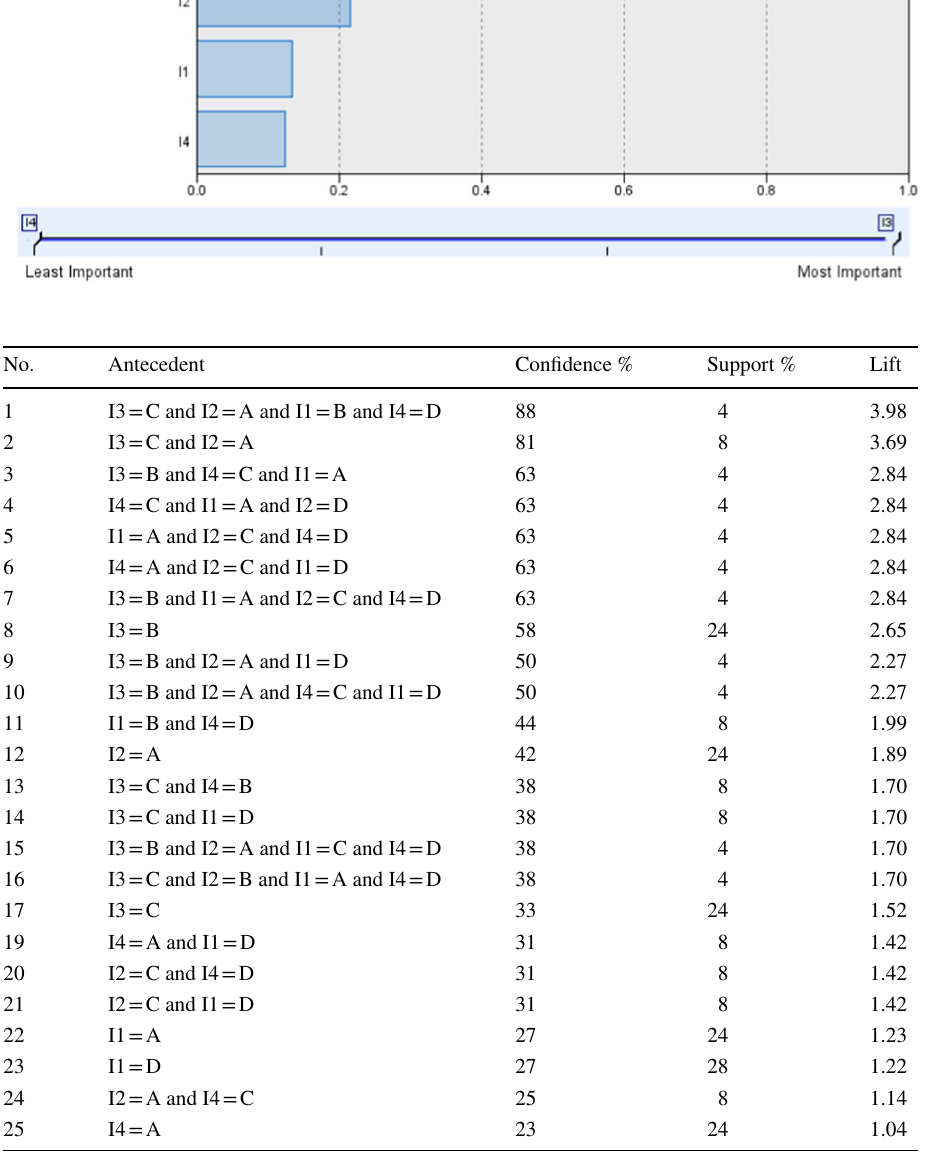
Fig. 8 The importance degrees of different deficit irrigation methods in predicting clusters by the CART algorithm